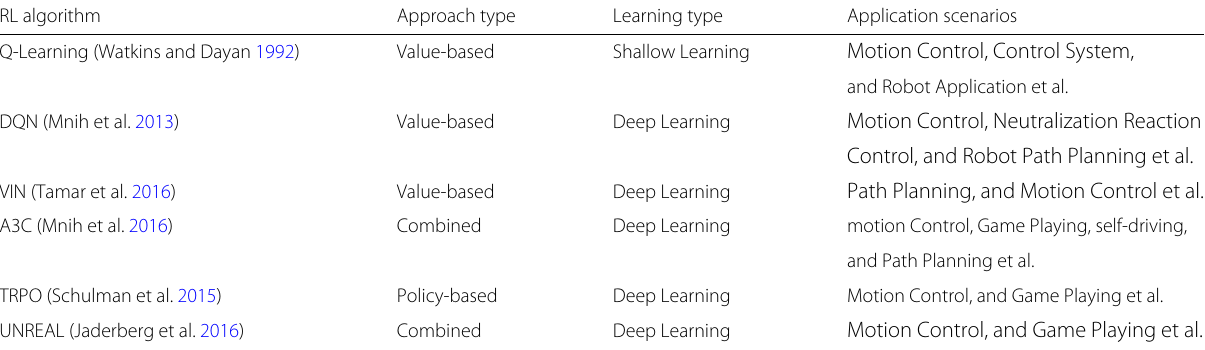
Table 1 The comparison of the most representation reinforcement learning algorithms RL